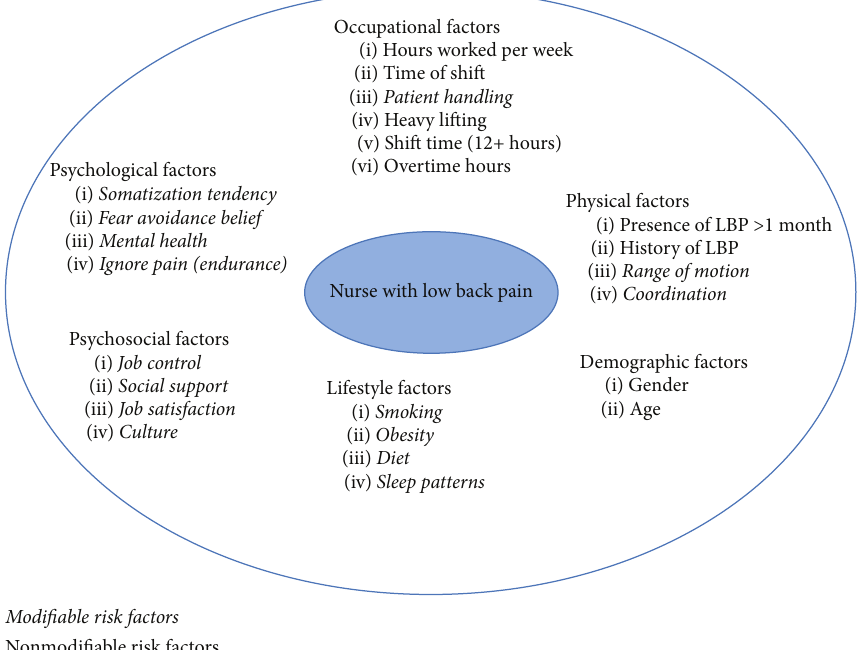
Figure 1: Proposed model of modifiable and nonmodifiable risk factors associated with chronic low back pain among nurses.